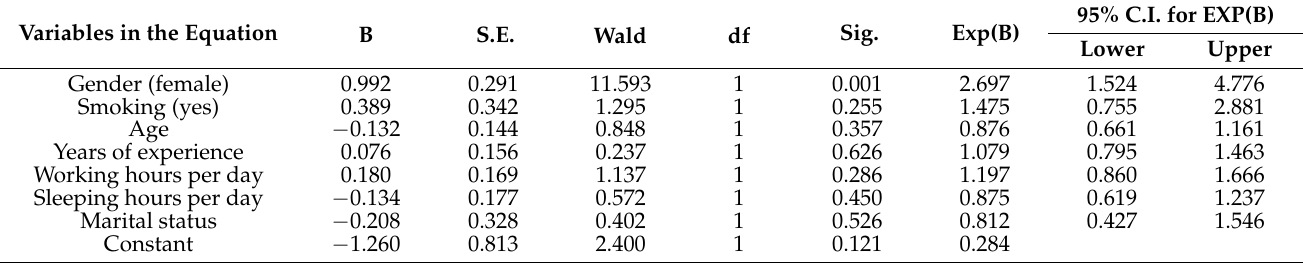
Table 5. Binomial regression results for shoulder disorder with different study characteristics.